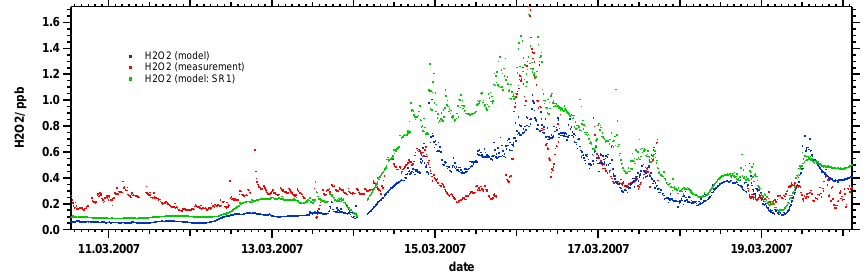
Figure 4. Time series of observed (red) and simulated (blue) hydrogen peroxide mixing ratios. In green a sensitivity simulation (SR1) of the model is shown with reduced dry deposition velocity (see text for details).